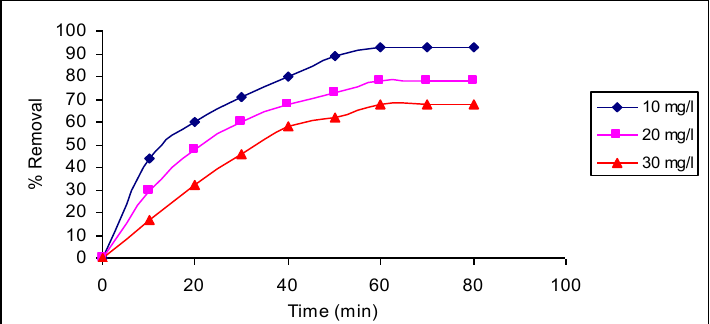
Figure 2. Relationship between agitation time and %removal of Chromium